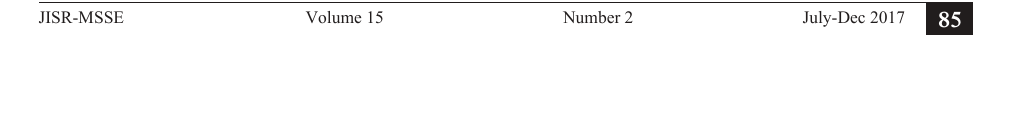
Hypotheses were tested with the help of t-test and regression analysis. Hypothesis were supported for p<0.05.